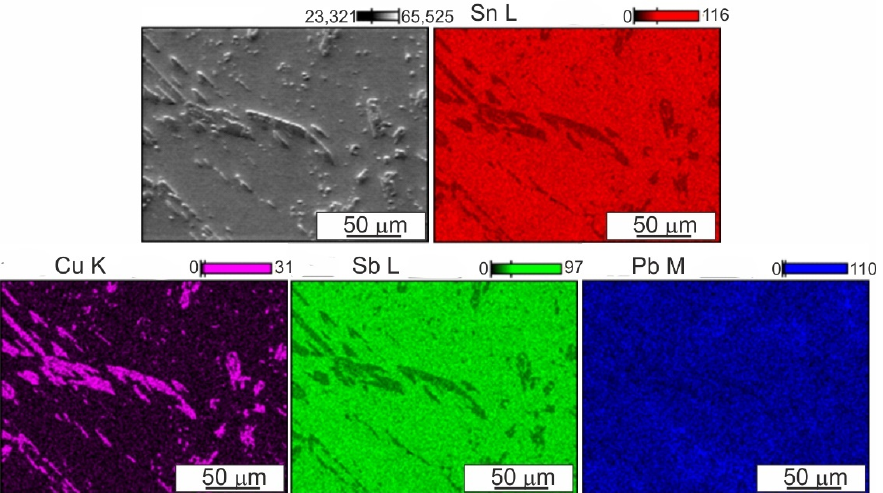
Figure 4. Microstructure and distribution maps of alloying elements (Sn, Cu, Sb, Pb) in B89 alloy in initial state, SEM EDS.